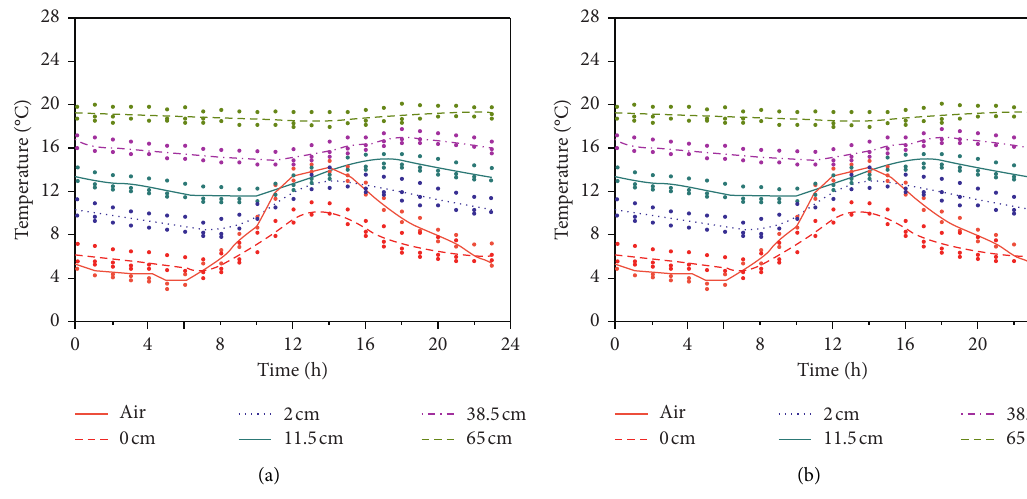
Figure 6: Air and pavement temperature profile over time in winter: (a) Site 1. (b) Site